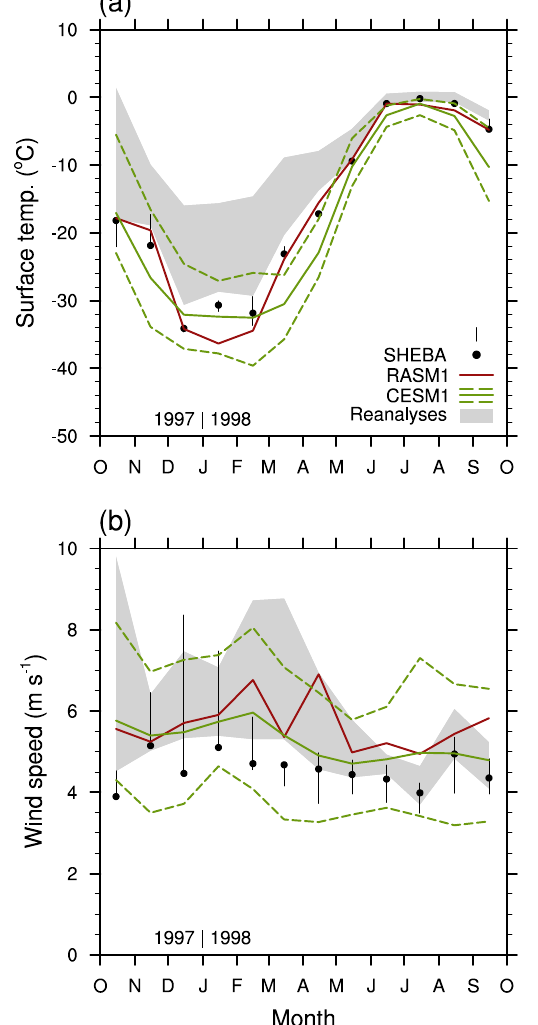
Figure 14. Comparison of monthly mean (a) surface temperature and (b) wind speed from SHEBA observations (black) with RASM1 (red), CESM1 (green), and reanalyses (gray shading). Observa- tional spread is indicated by the vertical lines extending from the circles, and the spread in reanalyses is shown by the gray shading. The green dashed lines surrounding CESM1 indicate the ensemble range (minimum to maximum).